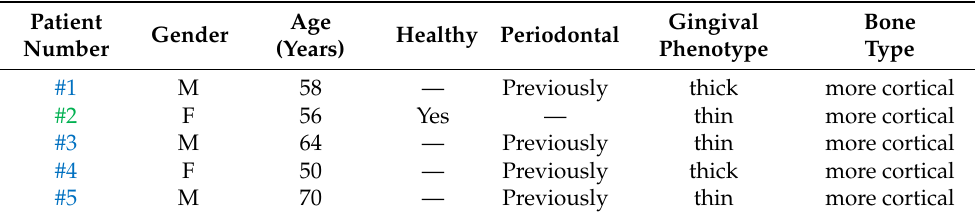
Table 1. List of patients involved in the study with clinical remarks; specifications regarding bone samples: ( • healthy), ( • previous